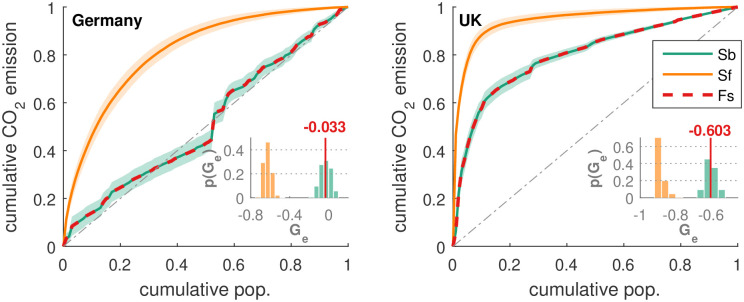
Robustness of Ge.In order to illustrate the robustness of the curves in Fig 3 we compare them with curves when the data is sub-sampled or shuffled. The panels for (a) Germany and (b) UK include the curves for the full samples (Fs), median and envelop for the sub-sampled data (Sb, green), and the median and envelop for the shuffled data (Sf, orange). The insets show histograms of the corresponding inhomogeneity indices. It can be seen that sub-samples of the data lead to similar results as for the full sample so that the results are not due to individual pixels. The Ge values from the shuffling approach −1, as the correlations between population and CO2 are destroyed.